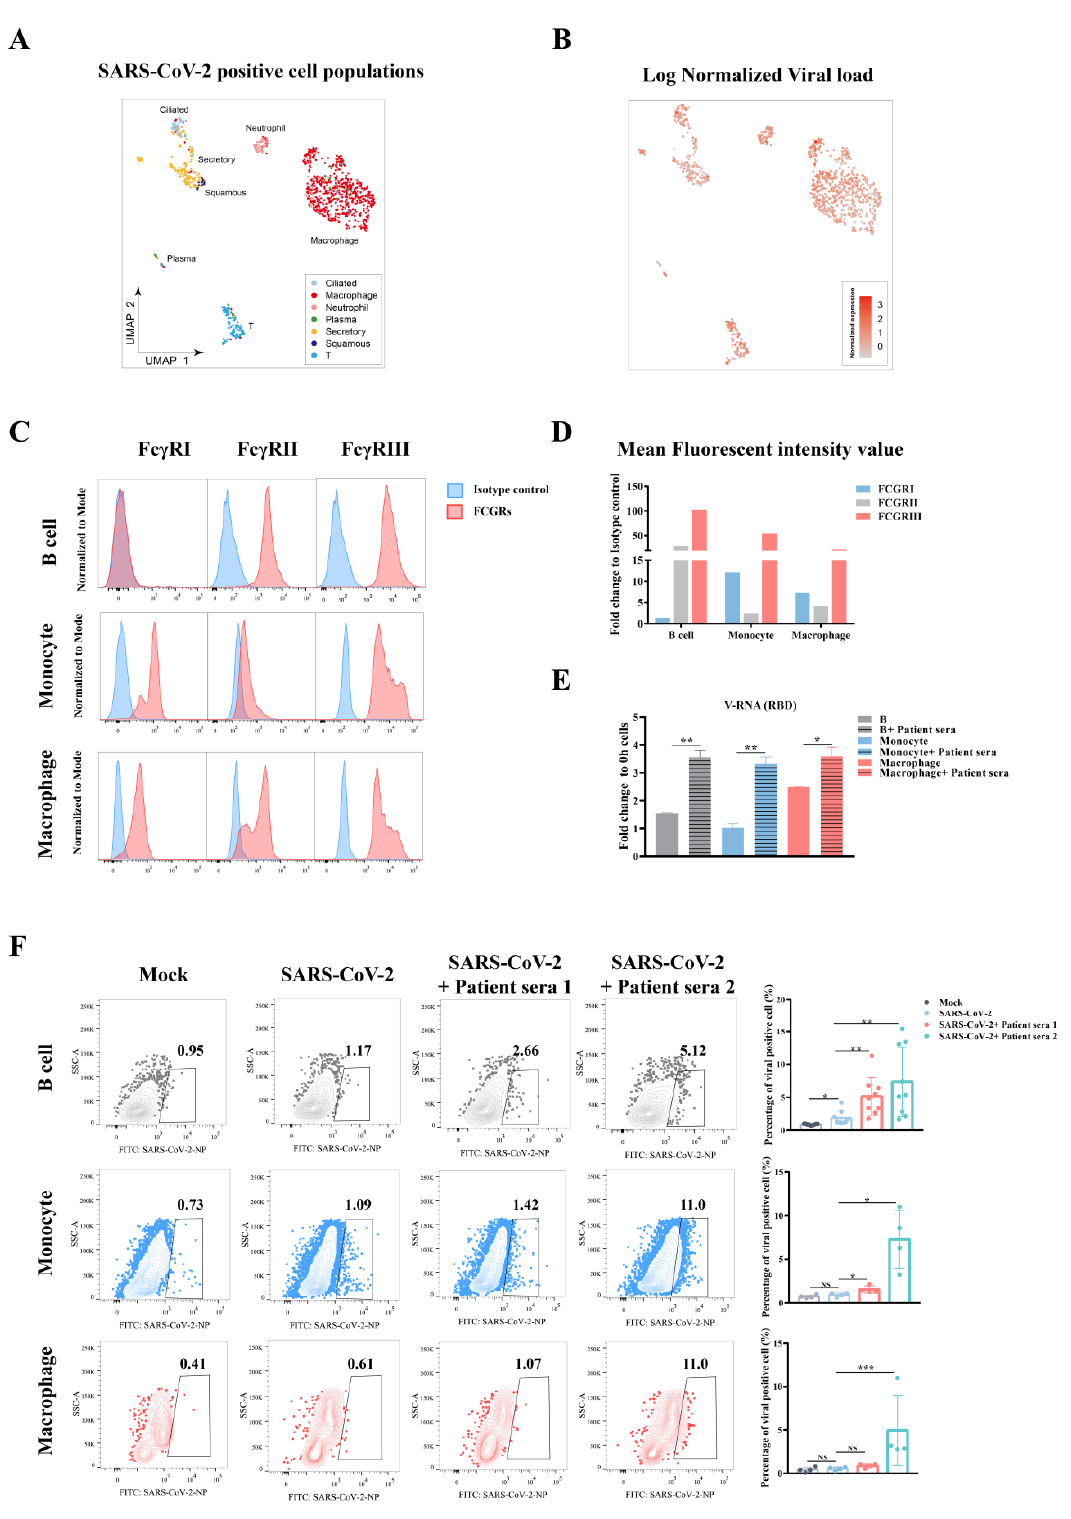
Figure 1. Convalescent sera from COVID-19 patients induced ADE in multiple peripheral blood immune cells. ( A ) UMAP show the overview of the population of SARS-CoV-2 RNA positive cells ( n = 1078), which were derived from BALF and two sputum samples of COVID-19 patients. Identification of cell population was corresponded to the description of a previous study [15]. ( B ) Normalized expression of SARS − CoV − 2 RNA in each virus positive cell. Data were reanalyzed from the published dataset [15]. ( C ) Expression of different Fc γ Rs including Fc γ RI, Fc γ RII, and Fc γ RIII on primary B cells, monocytes, or macrophages was detected by flow cytometry. ( D ) Quantification of Fc γ R expression by comparing the mean fluorescent intensity value. ( E ) SARS − CoV − 2 virus pretreated with equal − volume convalescent sera